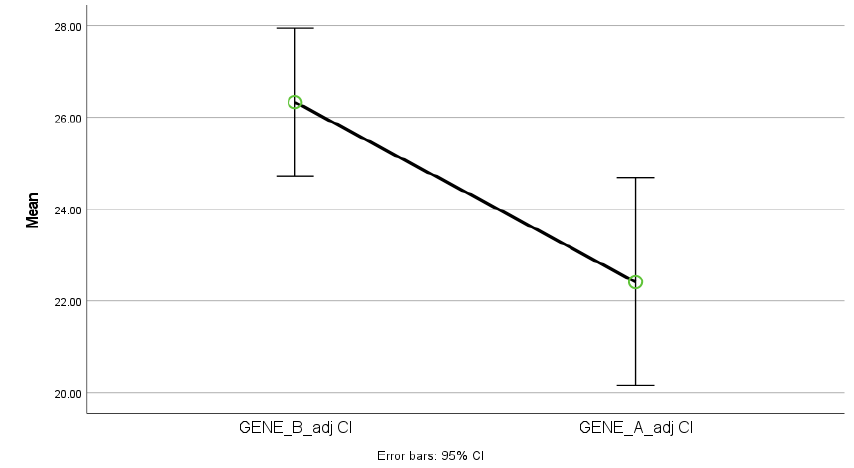
Figure 2. Adjusted 95% confidence interval for the two groups.